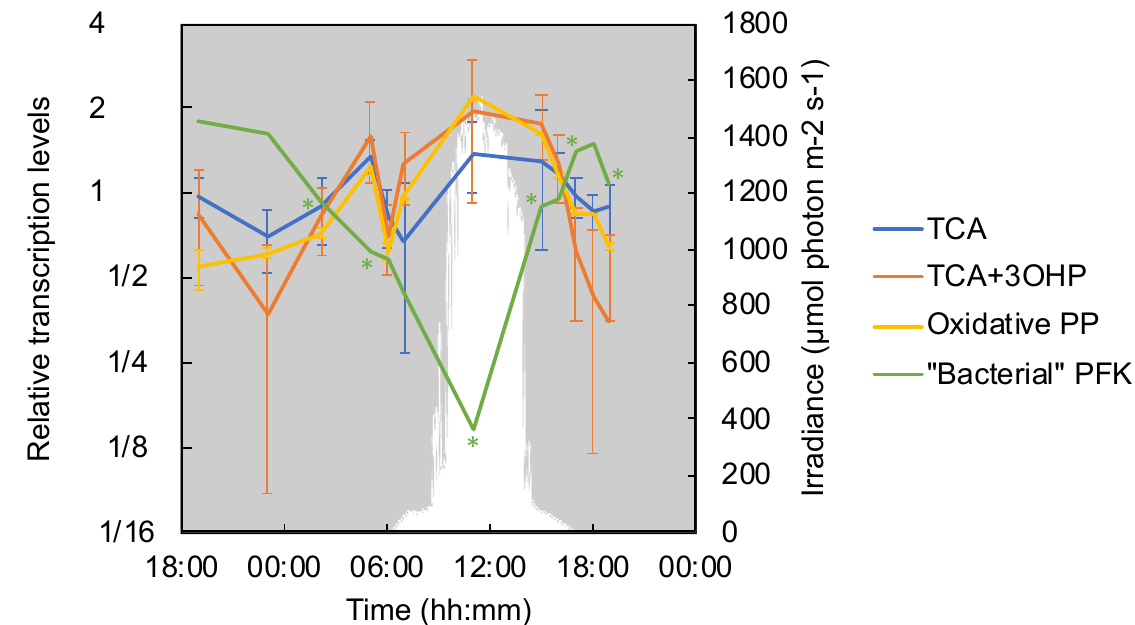
Figure 8. Relative transcription levels of genes for carbohydrate metabolism. The mean values of the relative transcriptional levels for the TCA cycle (Cagg_3738, 3721, 2500, and 2290) and common enzymes of the TCA cycle and the 3-OHP bi-cycle that is labeled as ‘TCA+3-OHP’ (Cagg_2086, 2819, and 1576–1578) are represented by a blue line and an orange line with standard deviations. The mean values of the relative transcripts of genes encoding key enzymes of the pentose phosphate pathway (Oxidative PP)—i.e., glucose-6-phosphate dehydrogenase (Cagg_3190) and 6-phosphogluconate dehydrogenase (Cagg_3189)—are represented by the yellow line with standard deviation. The values of the relative transcription levels are displayed for genes encoding the ‘bacterial’ type of the 6-phosphofructokinase that is labeled as “Bacterial” PFK (Cagg_3643, green line). The downwelling photon irradiance (PAR; 400–700 nm) is indicated in white. The asterisk indicates the transcription of a particular gene corresponding to the color in a timepoint differed significantly from that in the previous timepoint.